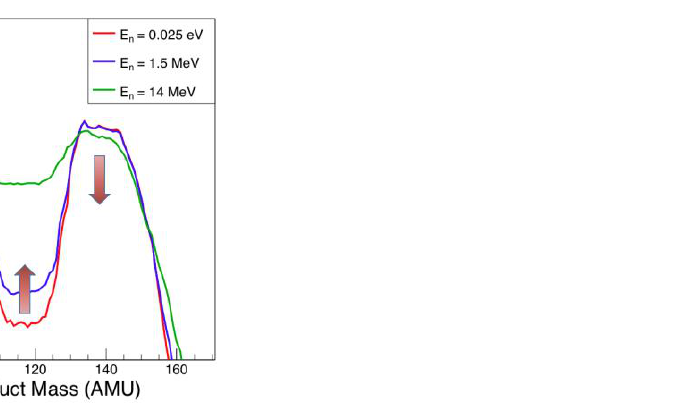
Figure 6. Fission product yield for various neutron energy bombardment. 99 Mo yield from fission is 6% of all the fission products. Adapted from data from T.R. England and B.F. Rider, LA-UR-94-3106 (1994).